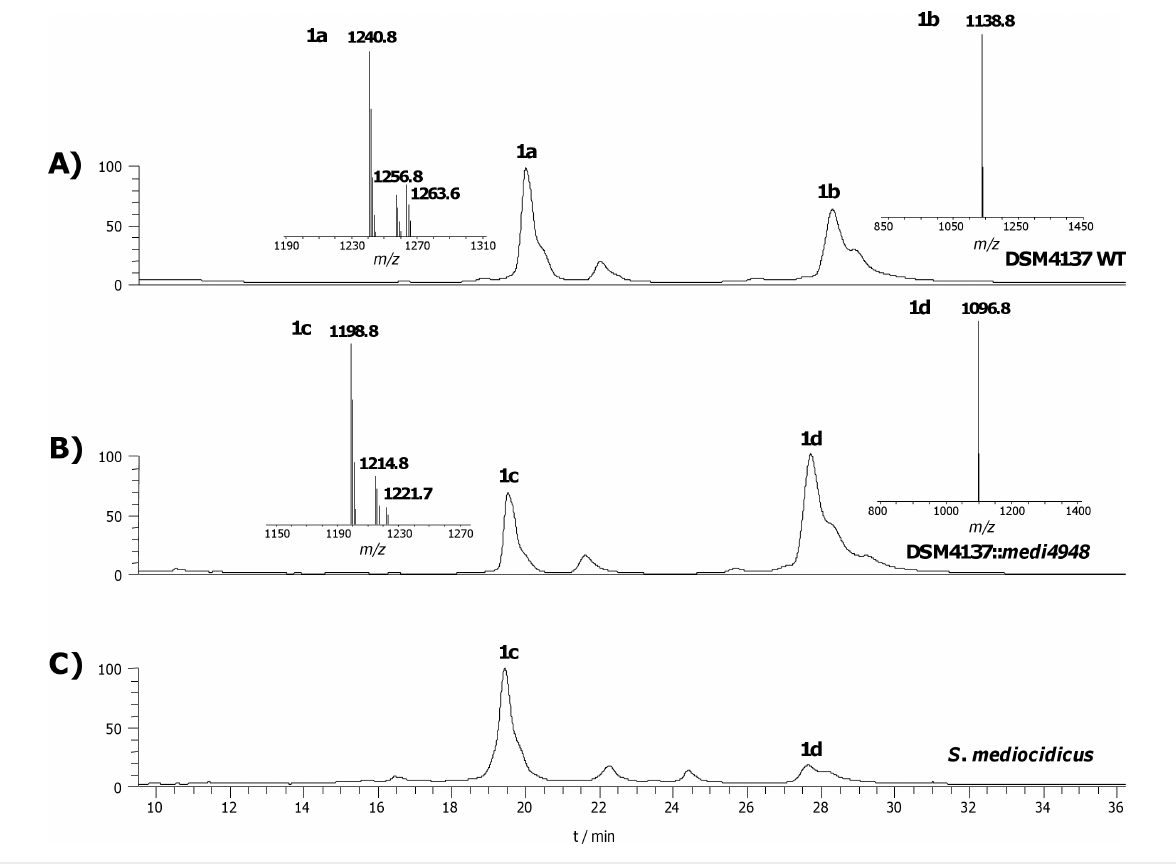
Figure 1: HPLC–UV–MS analysis of polyenes. A) LC–UV (360 nm) trace of mycelium methanol extract from DSM4137 wild type, showing the produc- tion of clethramycin ( 1a ) and desulfoclethramycin ( 1b ) at m/z 1240.8 ([M + Na] + ) and 1138.8 ([M + H] + ) , respectively. B) LC–UV (360 nm) trace of mycelium methanol extract from DSM4137 complemented with amidinohydrolase gene medi4948 from S. mediocidicus , showing clethramycin ( 1a ) and desulfoclethramycin ( 1b ) are fully converted to the corresponding amino forms, mediomycin A ( 1c ) and mediomycin B ( 1d ) at m/z 1198.8 ([M + Na] + ) and 1096.8 ([M + H] + ), respectively. C) LC–UV (360 nm) trace of mycelium methanol extract from S. mediocidicus , showing the production of mediomycin A ( 1c ) and mediomycin B ( 1d